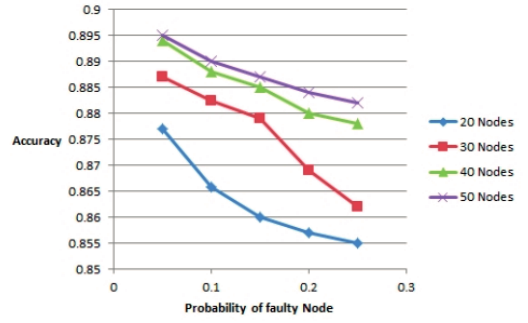
Figure 3. Probability of faulty node vs. accuracy.